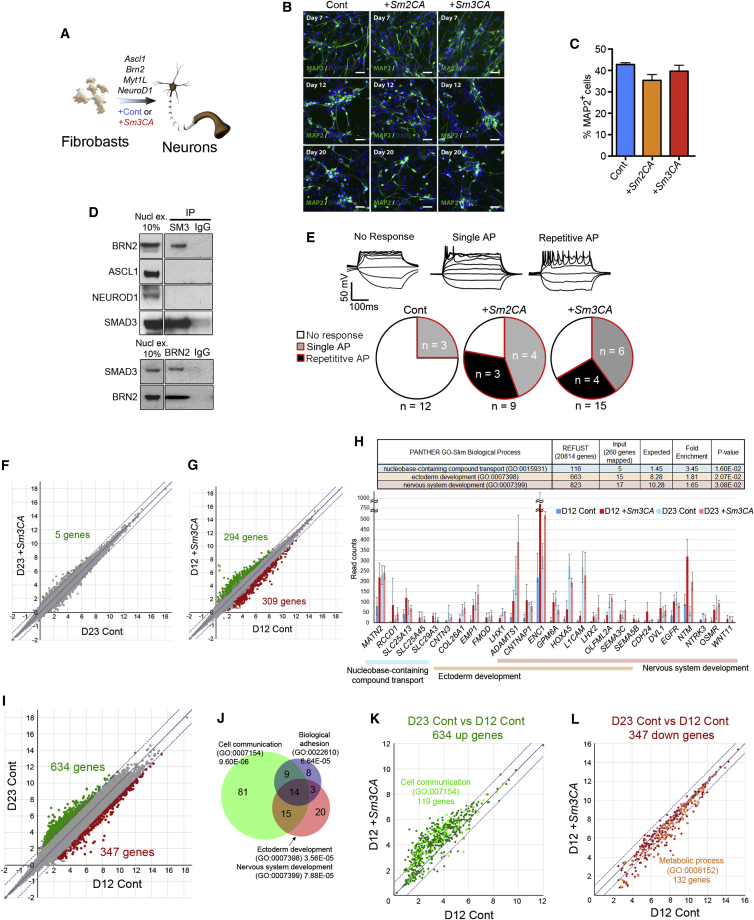
Smad3CA Accelerates the Generation of Mature iNs(A) Conversion of human fibroblasts to iNs by lentiviral transduction of Ascl1, Brn2a, Myt1L, and NeuroD1 (ABMN) with or without Smad2CA (Smad2CA) or Smad3CA (Sm3CA).(B) Confocal imaging of the neural marker MAP2 7, 12, and 20 days after viral infection with ABMN (Cont) or ABMN+Sm2CA or Sm3CA. Scale bars, 50 μm.(C) Quantification of MAP2+ cells (% of total cells) on day 12. Data represent averages of 2 independent experiments with 2 technical replicates.(D) Co-immunoprecipitation of BRN2 and SMAD3 when overexpressed in HEK293 cells.(E) Electrophysiological measurements using whole-cell patch clamp at day 23–25 post-conversion initiation using ABMN (Cont) or ABMN+Sm2CA or Sm3CA. Top panels represent traces of current-induced action potentials (APs) of different phenotypes.(F and G) Gene expression comparison between flow-sorted NCAM1+ABMN (Cont) and ABMN+Sm3CA iNs on day 23 (F) and day 12 (G). The x and y axis show log2 read counts; green and red genes, fold change (Fc) >2, FDR <0.1.(H) Expression of genes that have the top 3 most enriched gene ontology (GO) terms in the 294 upregulated genes in day 12 +Sm3CA iNs.(I) Differentially expressed genes between day 12 and day 23 iNs with ABMN (Cont) (Fc >3, FDR < 0.1).(J) Top 4 most enriched GO terms in the 634 upregulated genes on day 23, and number of genes with these GO terms.(K and L) Expression comparison of up-regulated (K) and down-regulated (L) genes highlighted in (I) between ABMN (Cont) and ABMN+Sm3CA iNs on day 12.See also Figure S6 and Table S2.